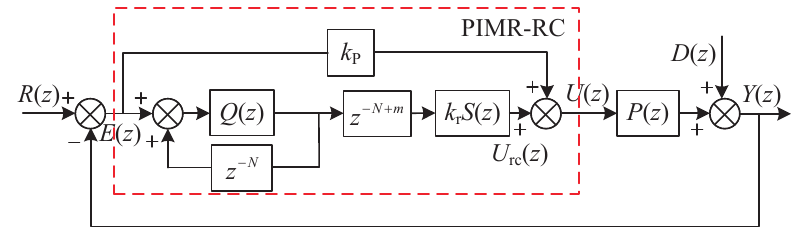
Figure 3. Block diagram of the PIMR-RC system.